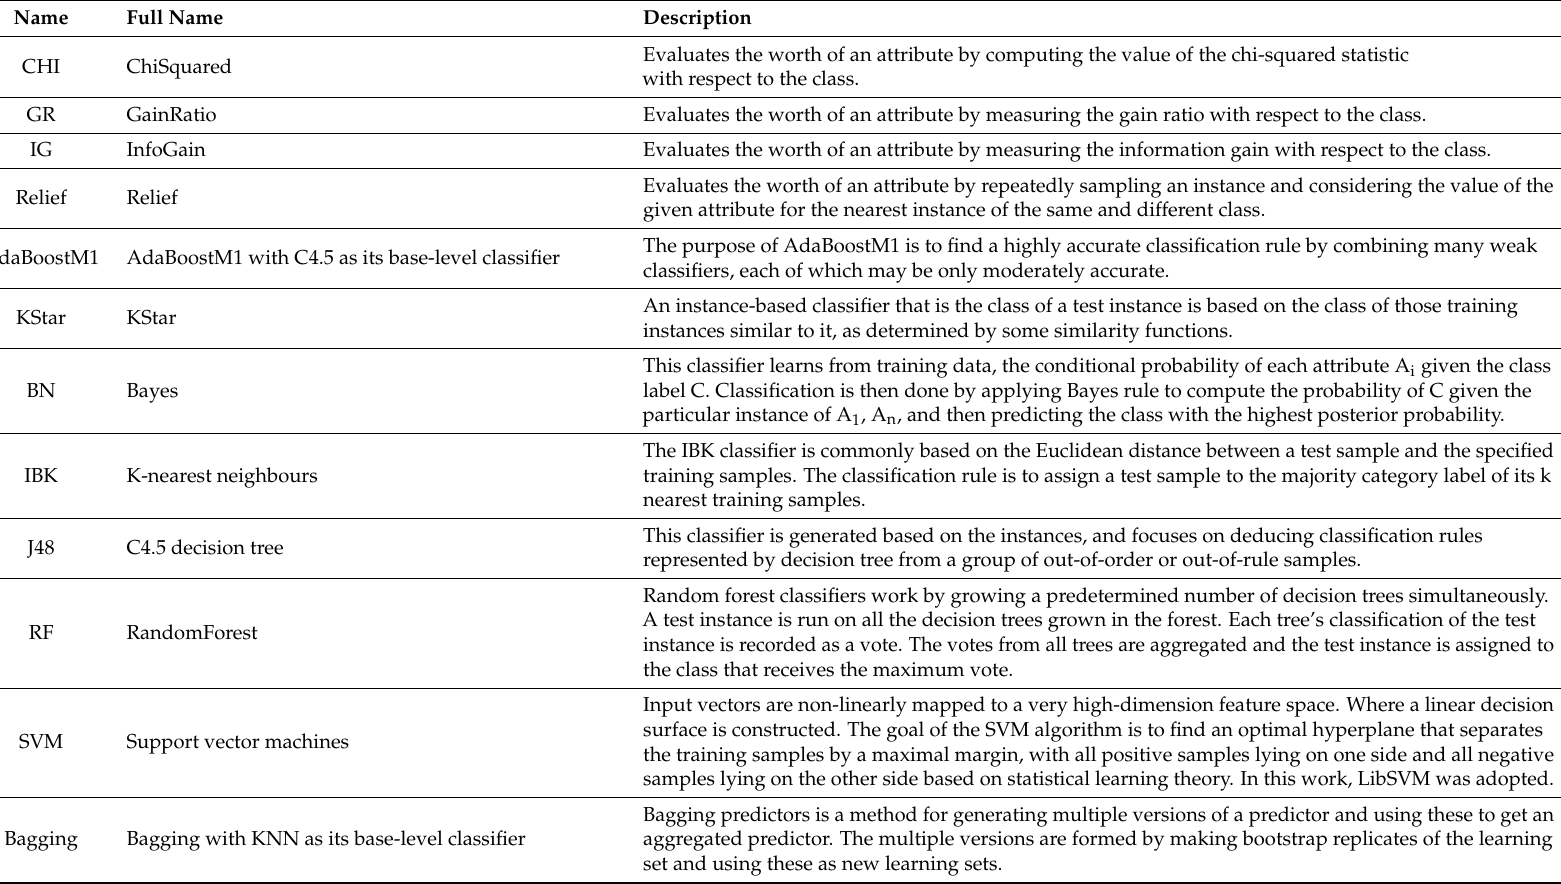
Table 7. Overview of FS algorithms and classifier